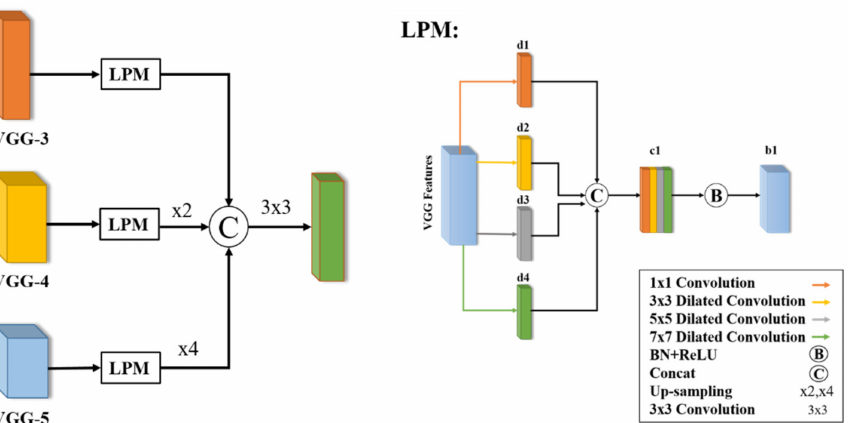
Figure 2. Detailed illustration of our local information concatenation module (LICM). It comprises three sub-branches, each of which contains a local perception module (LPM). LPM: local perception module comprises three sub-branches, each of which works with different receptive fields. After dilated convolution, all sub-branches (d1, d2, d3, d4) with the same number of channels (16) are combined to output activated